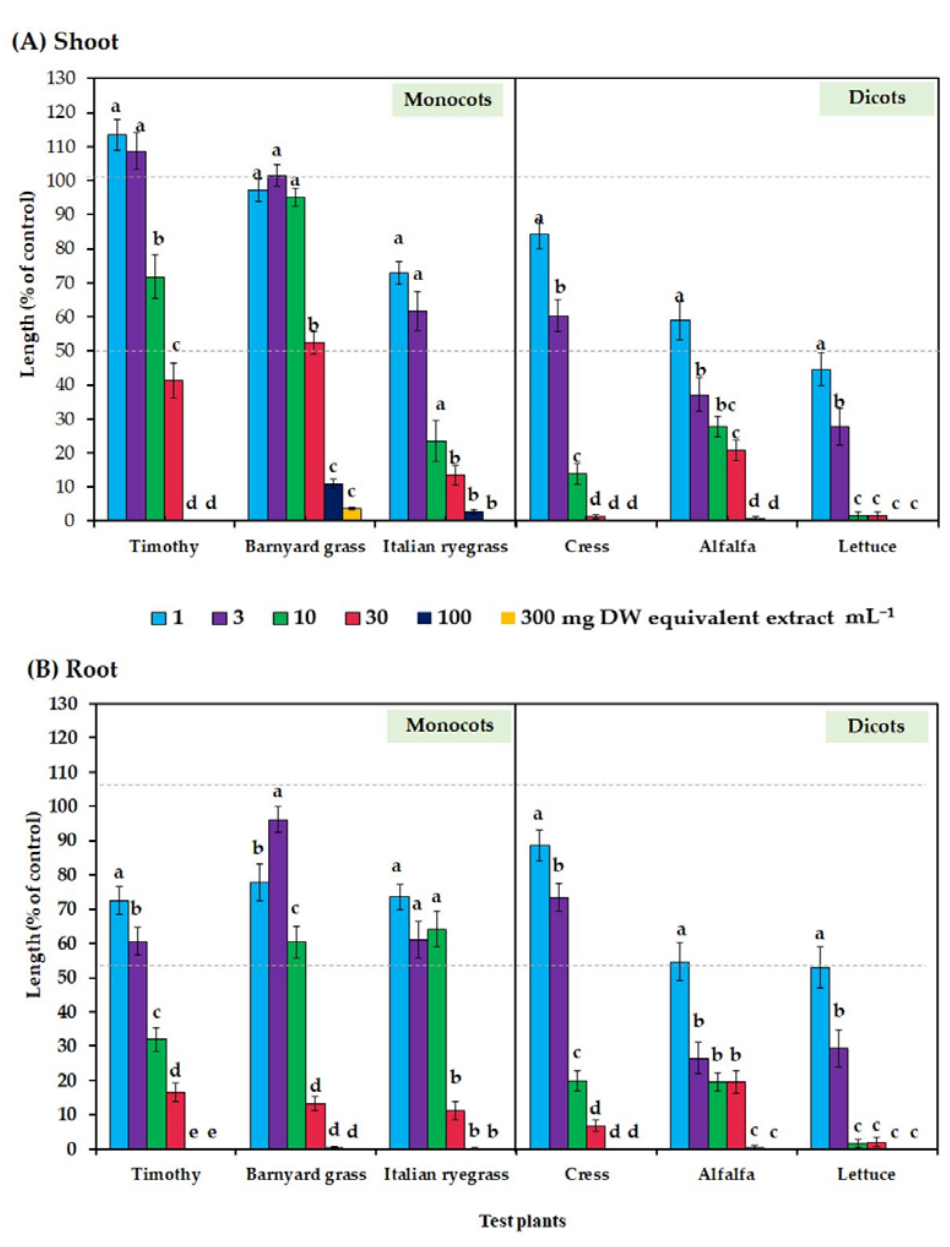
Figure 2. Growth inhibitory effects of the P. rosea extract on the ( A ) shoot and ( B ) root growth of all the tested plants. Error bars are standard errors of the mean from two independent experiments repeated three times with 10 seeds for each treatment ( n = 60). Different letters above the bars indicate significant differences between treatments (Tukey’s HSD, p ≤ 0.05). Table 1. EC 50 values of the P. rosea extracts for all the tested plants.